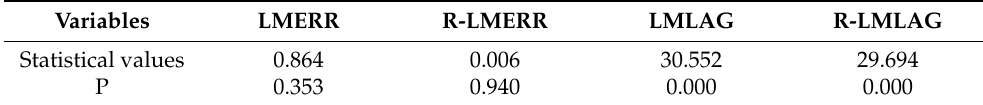
Table 2. Lagrange multipliers and their robust form test results. Variables LMERR R-LMERR LMLAG Statistical